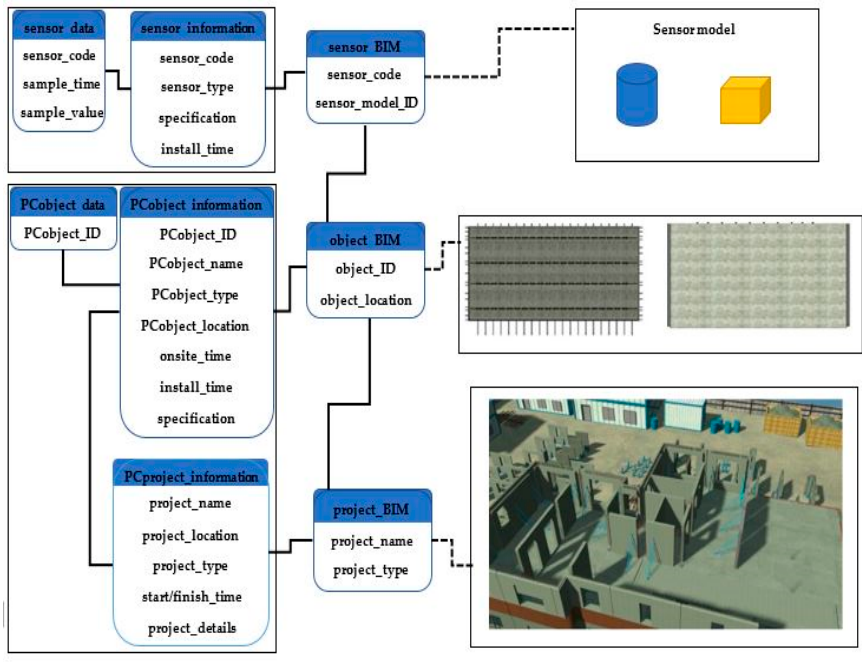
Figure 9. The information incorporated in BIM model.